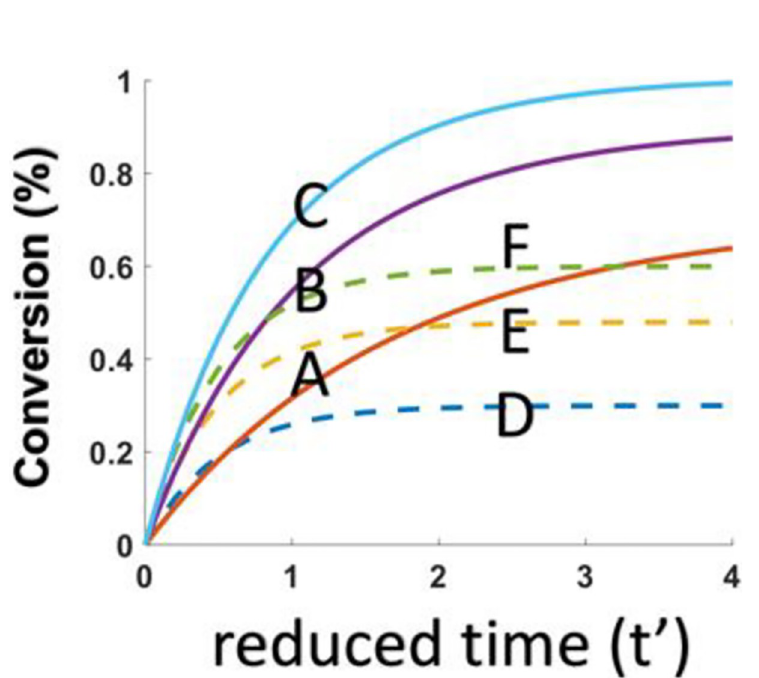
Fig 3. Efficacy of FRP and CP for various absorption coefficients b = (0, 0.5, 1.0), for fixed N 0 = 1.0 and B 0 = 0.6.